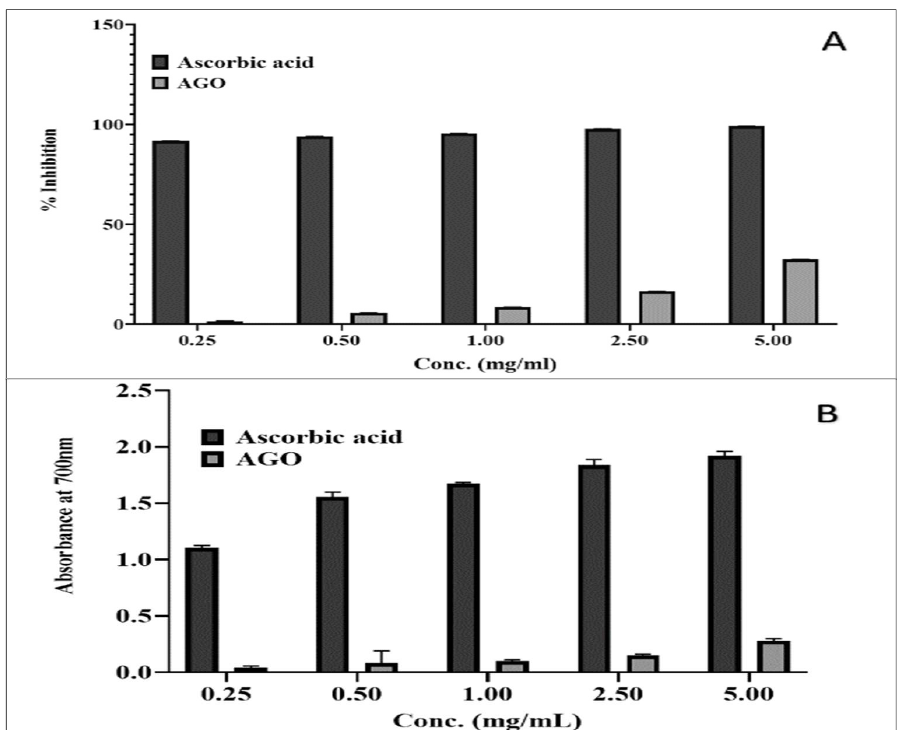
Figure 2. Antioxidant activity of the Apium graveolens oil (AGO), ( A ): DPPH; ( B ): FeCl 3 method.